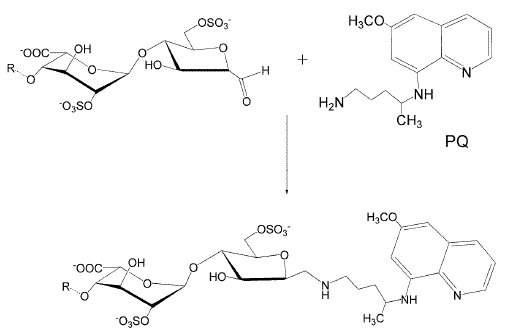
Figure 5. Reaction between the reducing end of heparin and primaquine (PQ), and the resulting molecular structure. Table 3. In vitro P. falciparum growth inhibition activity assay of the heparin-PQ conjugate.